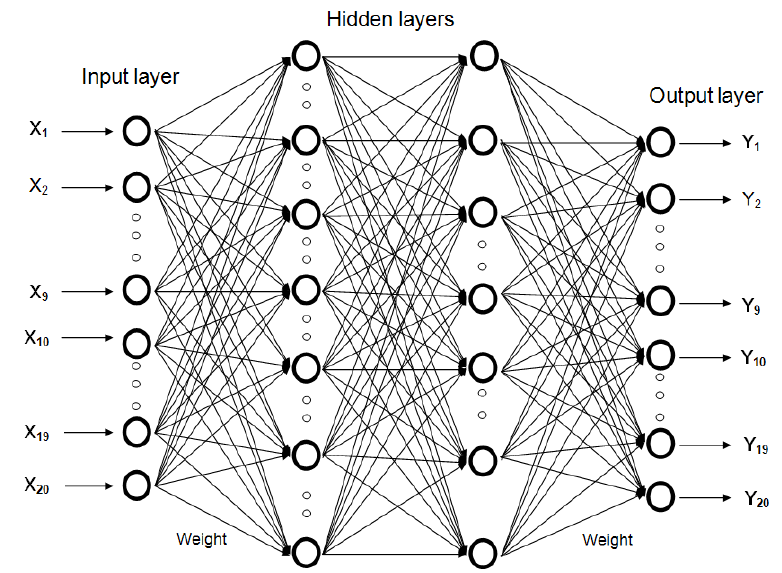
Figure 9. Multi-layer ANN model.